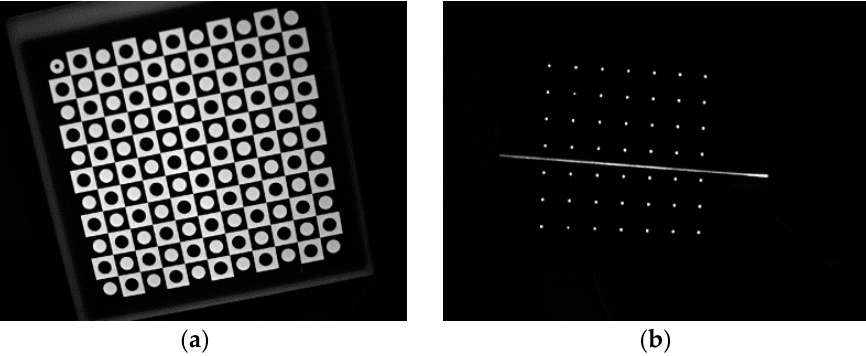
Figure 3. The images of the planar targets. ( a ) The planar target image for the intrinsic parameters’ calibration. The target contains 10 × 10 checkers at the interval of 10 mm, and the precision is 0.02 mm; ( b ) The planar target image for the structured light calibration. The target contains a 7 × 7 dot matrix at the interval of 12 mm, and the precision is 0.02 mm.